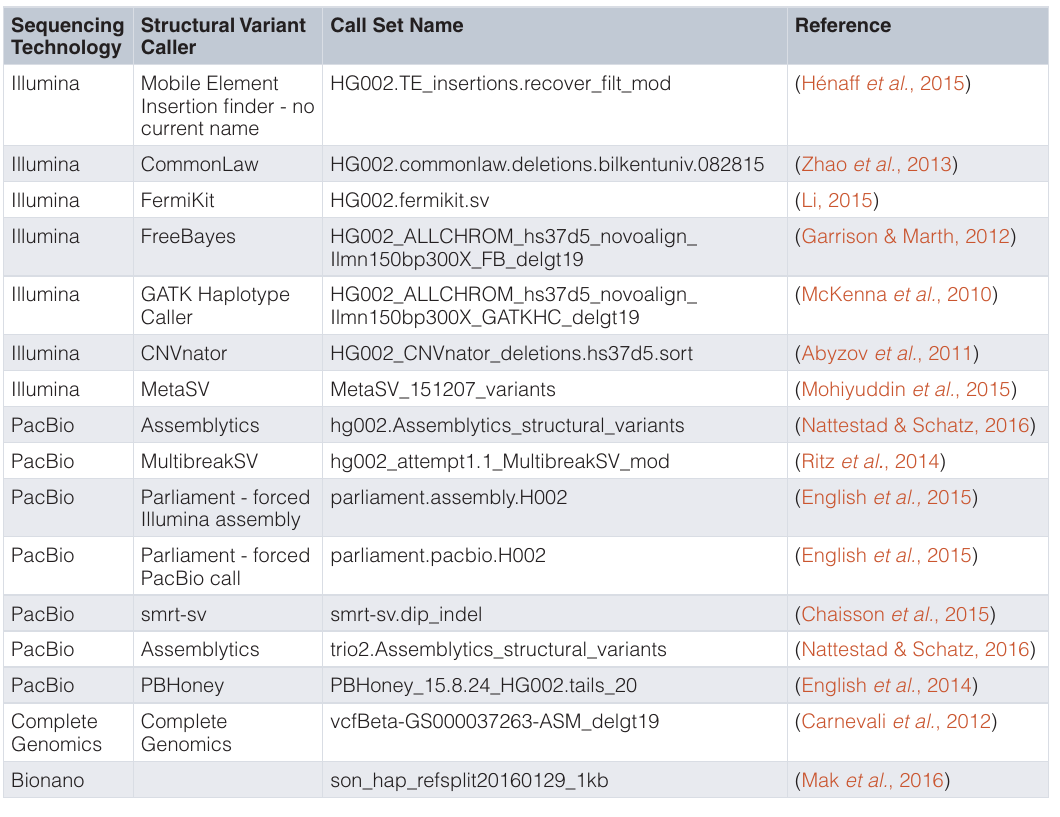
Table 1. Structural variant callsets for the Ashkenazi son.